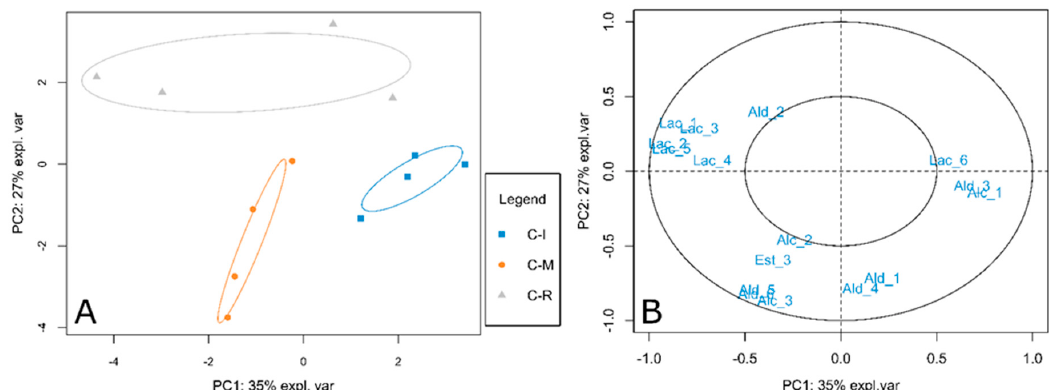
Figure 1. ( A ) Two-dimensional principal component analysis (PCA), elaborated using the VOCs quantified by the GC-MS at harvest for the three maturity classes (C-I: immature; C-M: mature; C-R: ripen. The ellipse confidence level is set at 0.5 (50% region). ( B ) Variable plot projecting the variables (VOCs) identified at harvest. VOCs ID is reported in Table 1. Two circumferences of radius 1 and 0.5 are plotted to report the correlation structure of the variables.